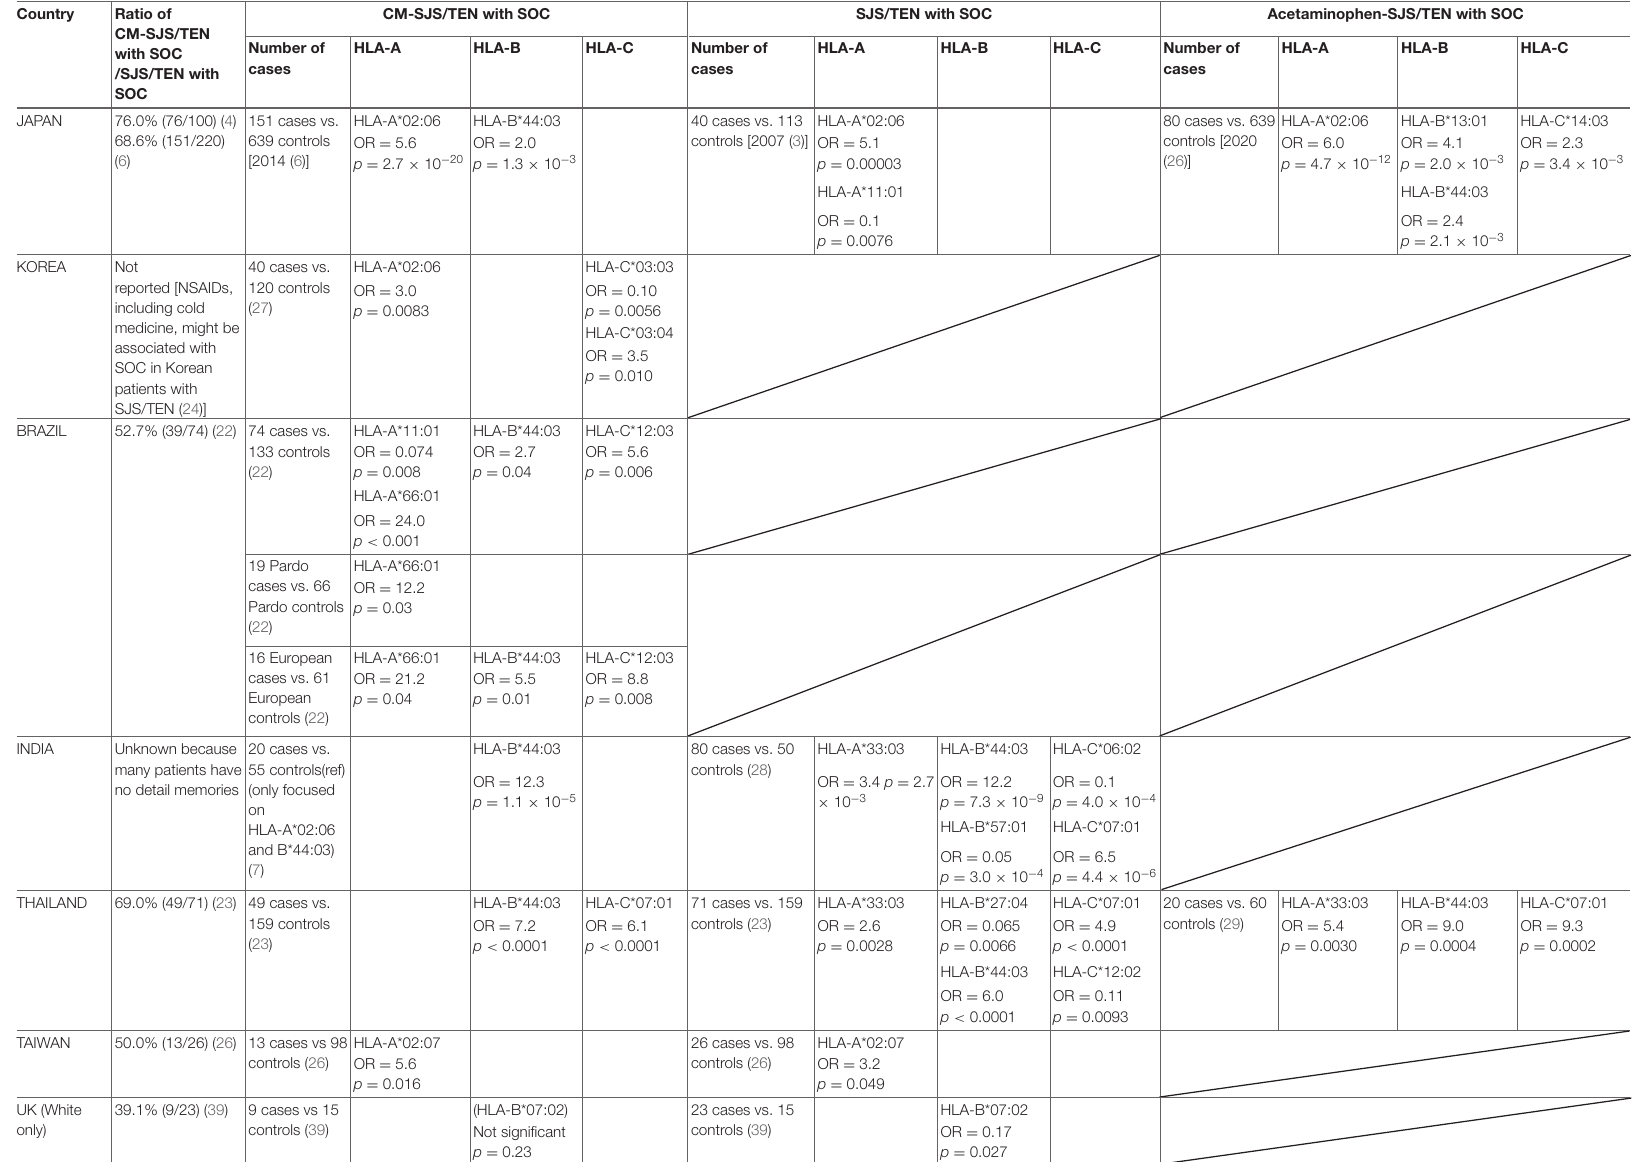
TABLE 1 | Carrier frequencies of each country.